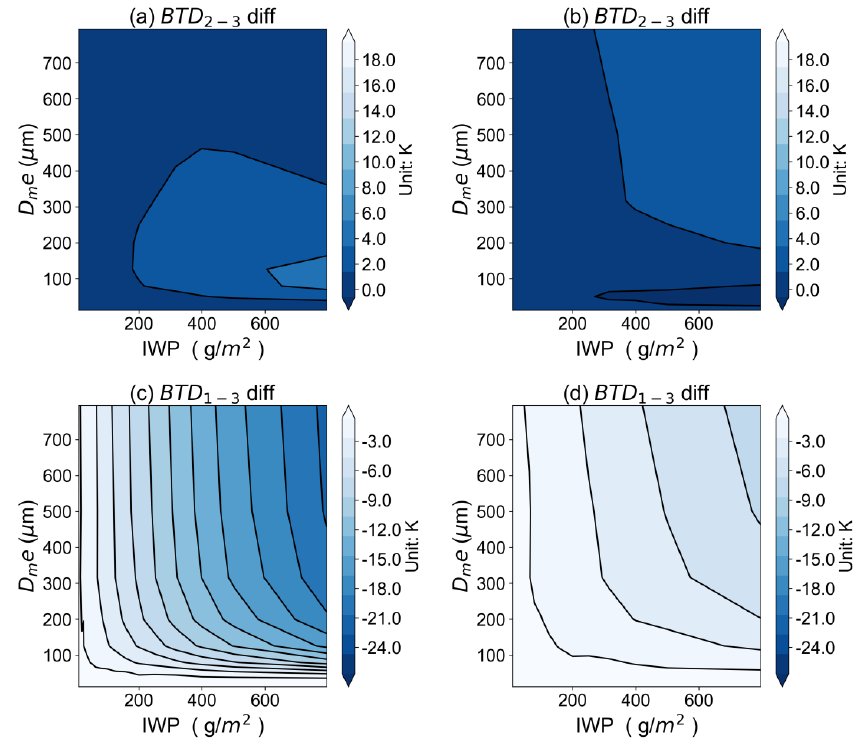
Figure 8. The BTD 2–3 and BTD 1–3 differences for the (a, c) Voronoi-minus-sphere and (b, d) Voronoi-minus-column ICS models as functions of the IWP and D me ,